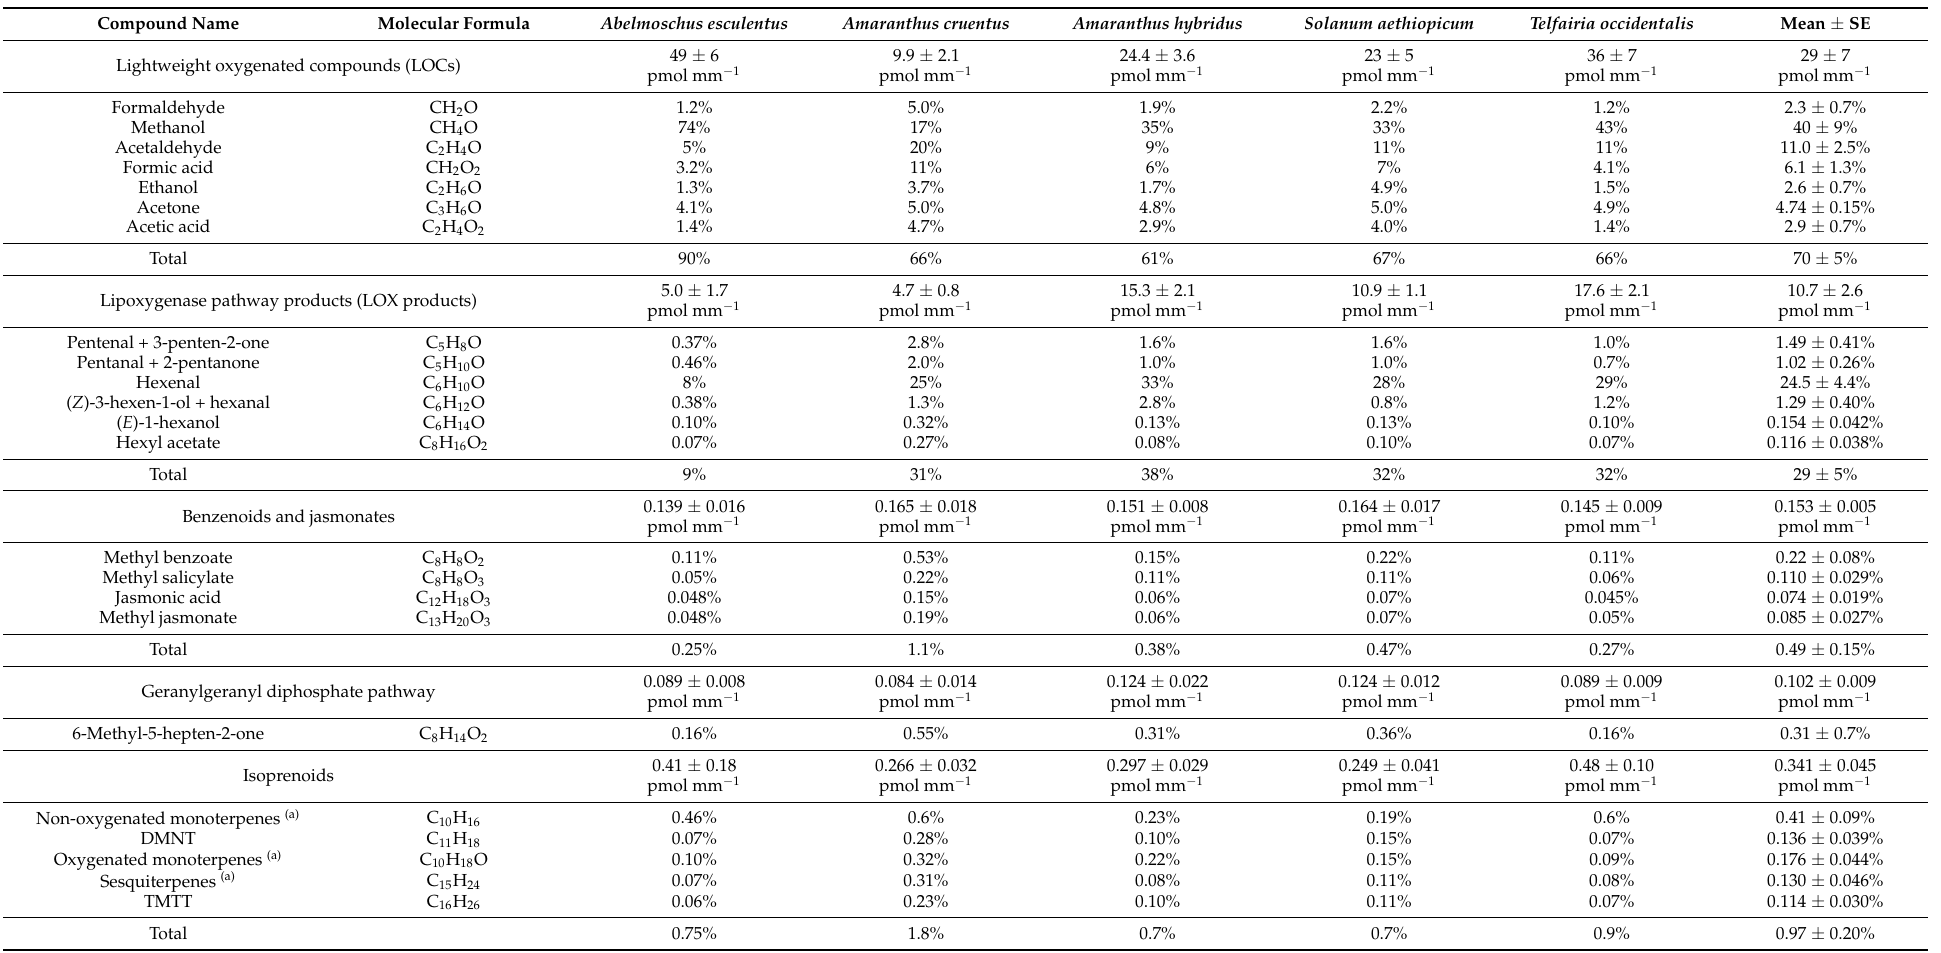
Table 3. Chemical composition of the overall blend of VOCs emitted after a 12 mm cut was made into the leaf lamina. Values are expressed as percentage contribution to the total emissions, and in pmol mm − 1 in the summary per VOC classes. More emission peak information is found in Table